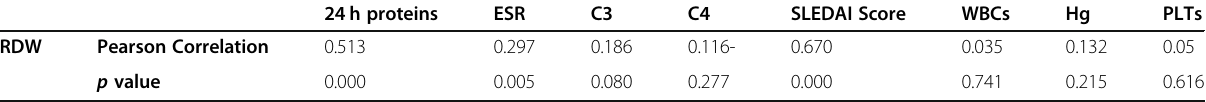
Table 5 Correlation between RDW and activity indices indicating positive correlation with 24 h urine proteins and SLEDAI score